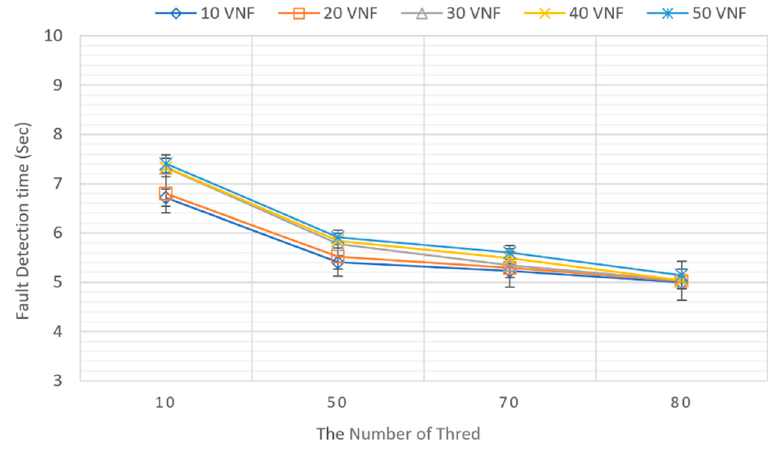
Figure 15. Resource fault monitoring performance.